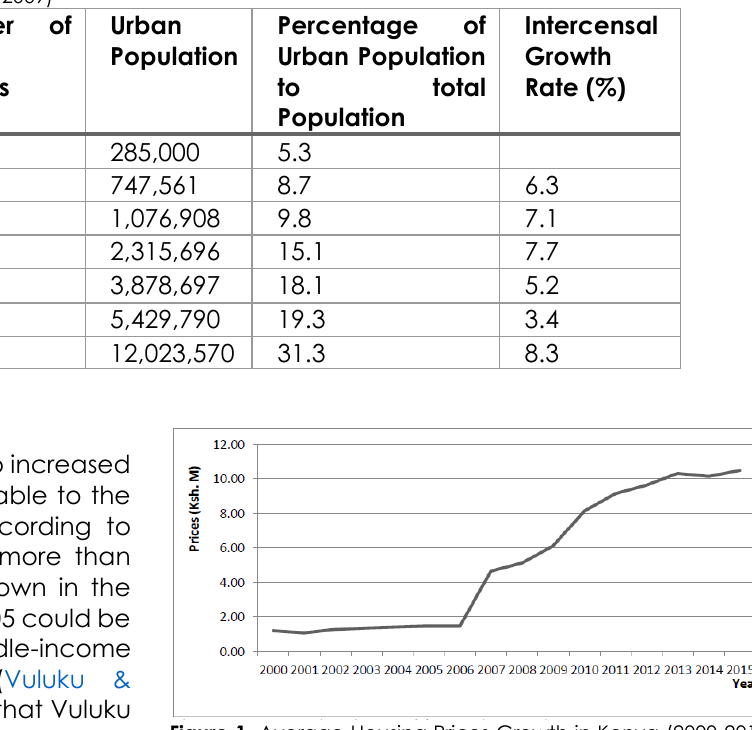
Figure 1. Average Housing Prices Growth in Kenya (2000-2015) (Njaramba,